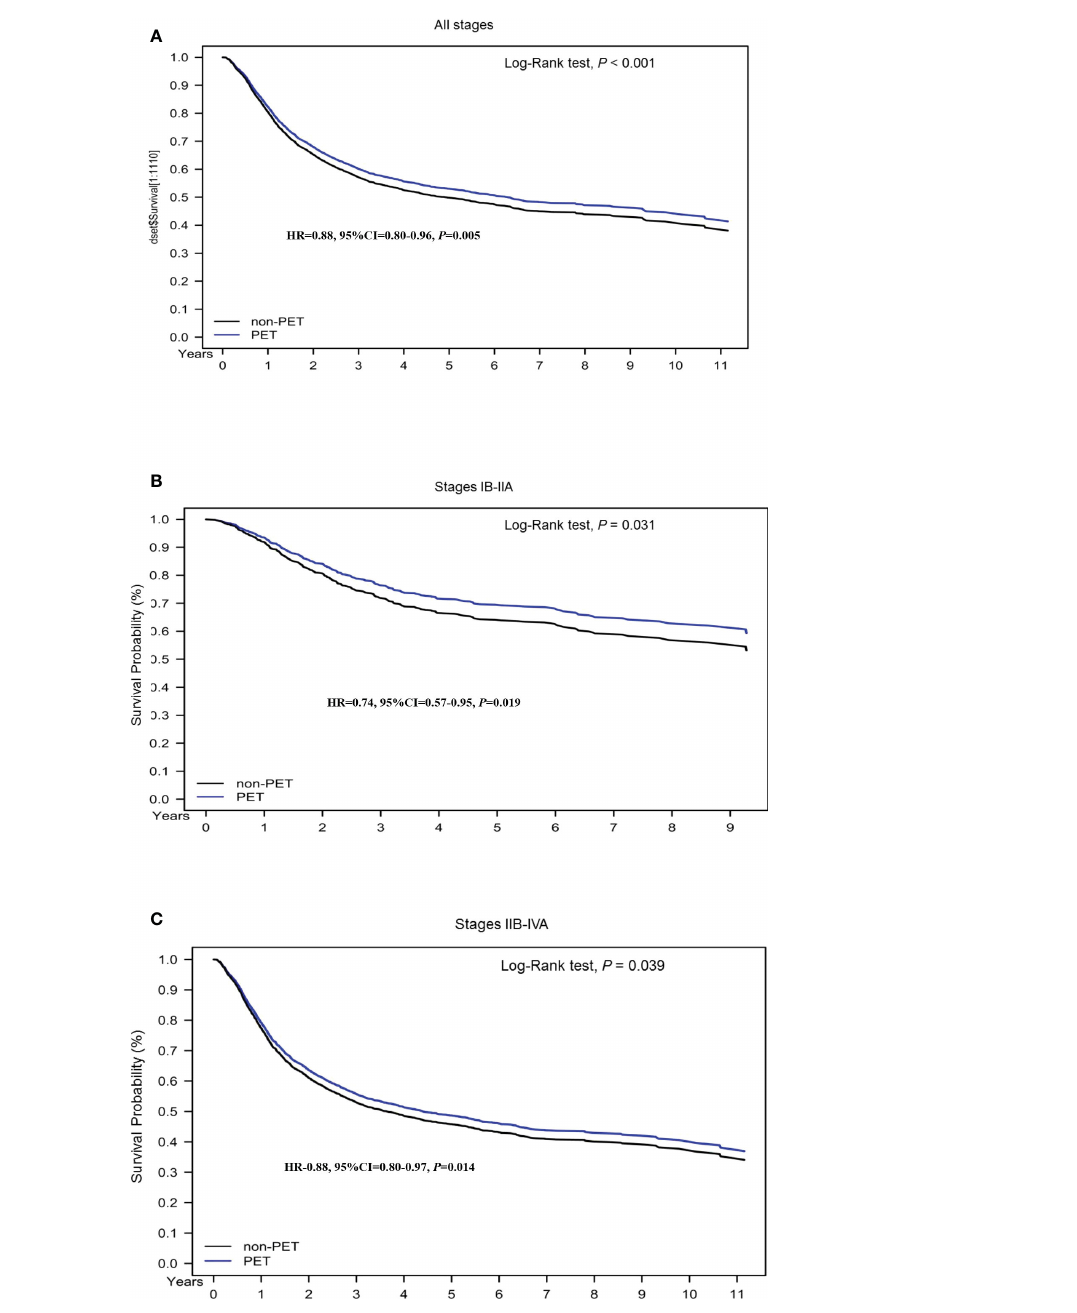
FIGURE 1 Kaplan – Meier overall survival curves for propensity score – matched patients with cervical cancer. (A) All stages; (B) stage IB – IIA; (C) stage IIB –